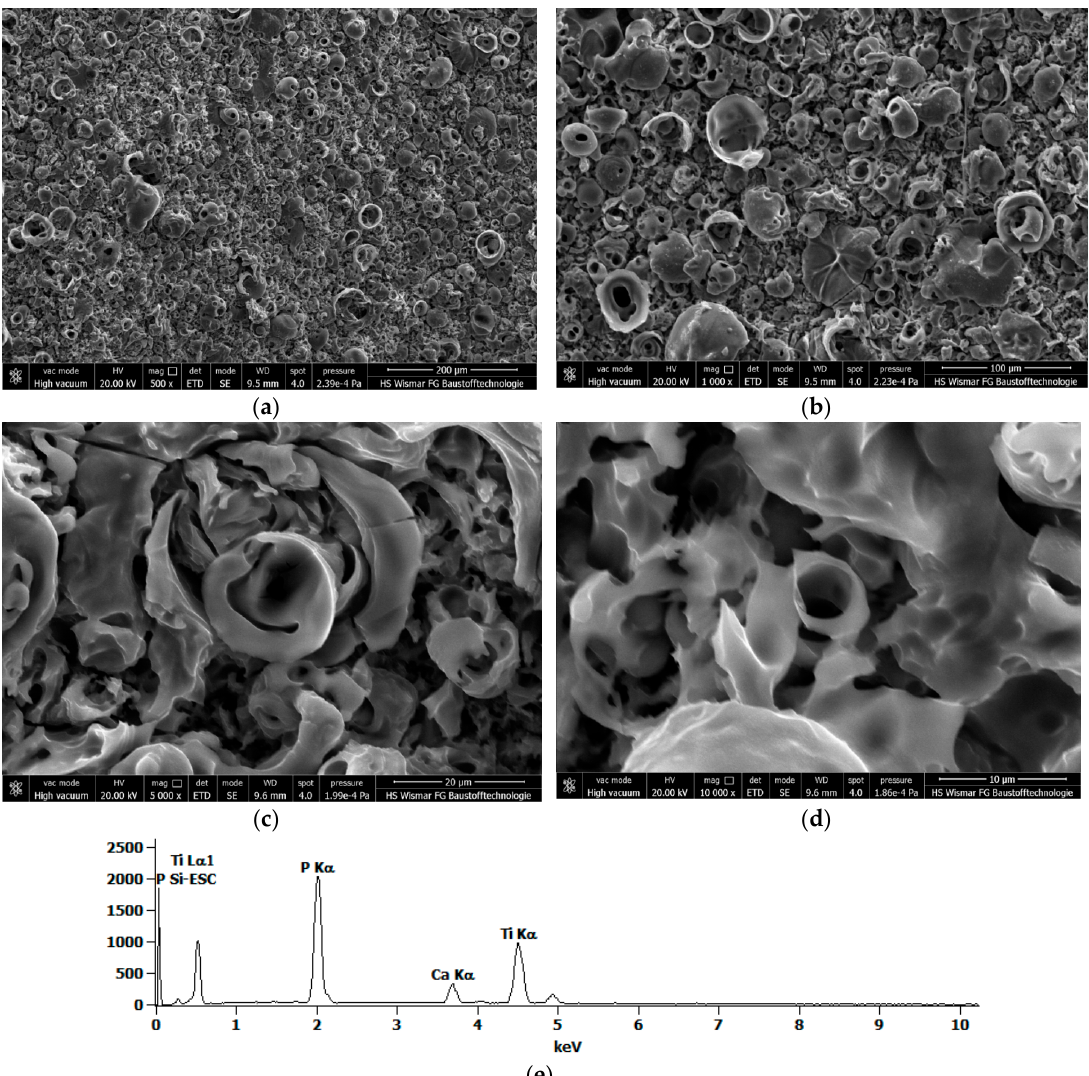
Figure 8. SEM pictures ( a – d ) and EDS spectrum ( e ) of the porous coating formed on CP Titanium Grade 2 after PEO treatment at a voltage of 650 V DC in 500 g Ca(NO 3 ) 2 ·4H 2 O in 1000 mL H 3 PO 4 electrolyte. Magnifications: ( a ) 500×, ( b ) 1000×, ( c ) 5000×, ( d ) 10,000×.